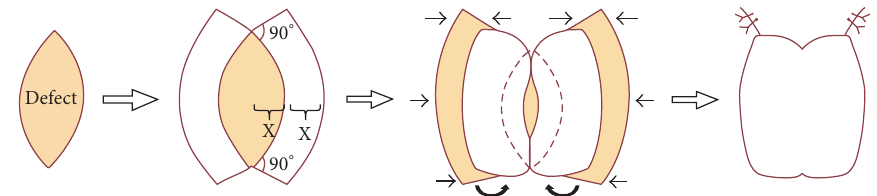
Figure 3: Double keystone flaps (modification from Bhat [6]).